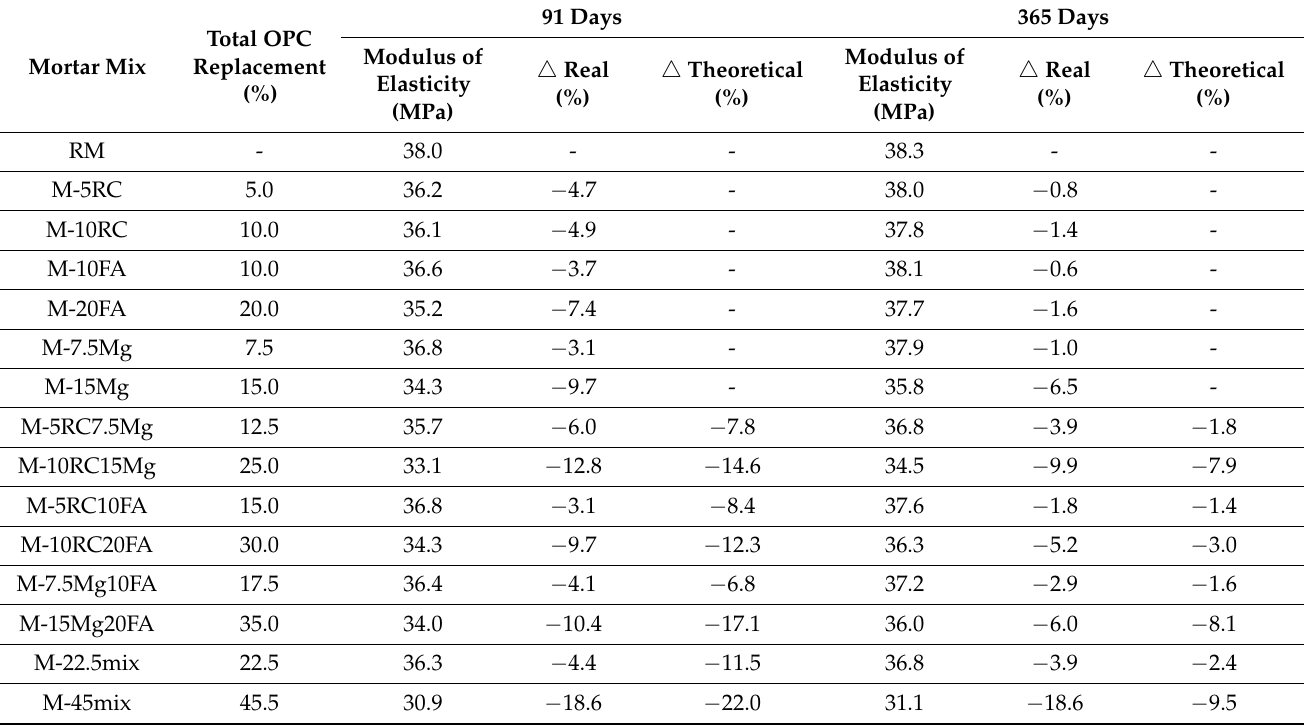
Table 8. Dynamic modulus of elasticity at 91 and 365